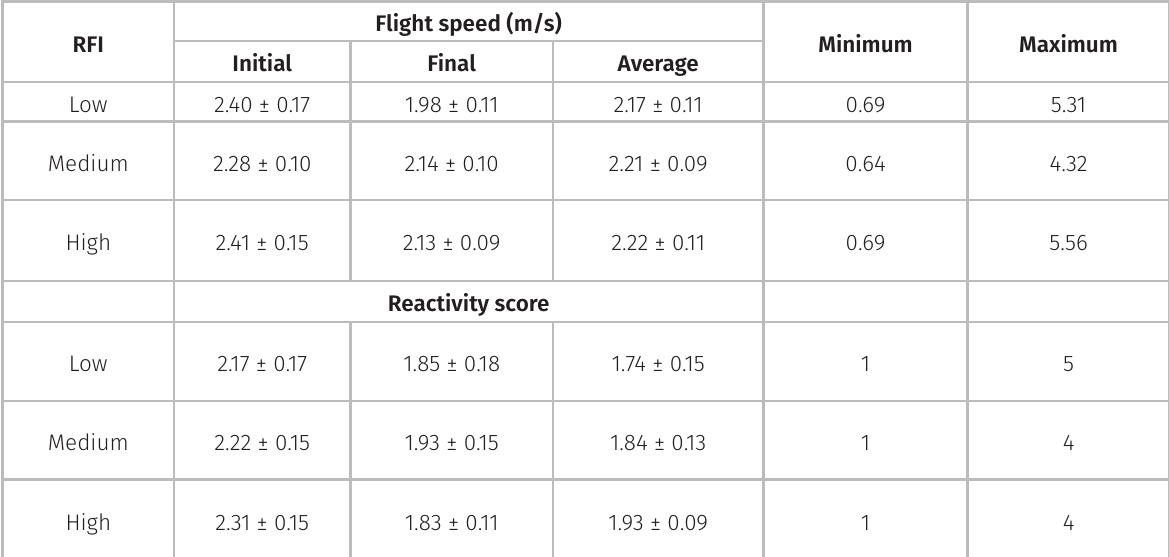
Table V. Flight speed and reactivity score of Nellore bulls classified according to their residual feed intake